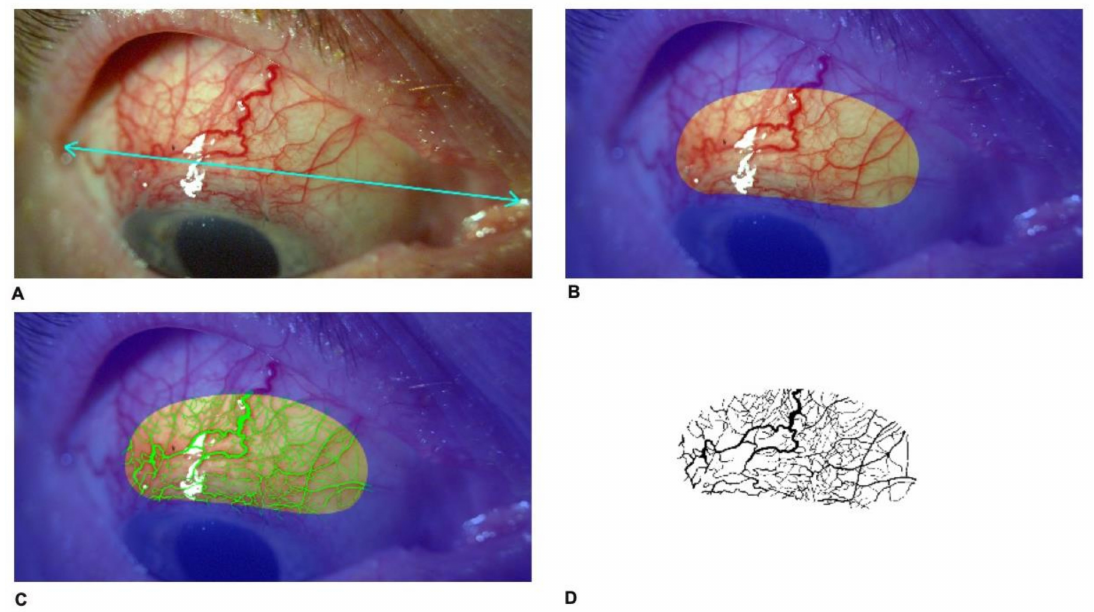
Figure 1. Slit-lamp anterior-segment photography of a filtering bleb 1 day after trabeculectomy. ( A ) Setting reference points (eye corners) on each standard photography in 10 × magnification (blue arrow). ( B ) Creation of a constant bean-shaped area of 4.994 cm 2 including scleral flap. ( C ) Adjusting the brightness of an image, increasing the contrast in RGB (red–green–blue) color model and enhancement of the green channel. The threshold was manually adjusted until the entire red area of vessels was highlighted in green. ( D ) After color correction of the photographs, processed masks were recorded as monochromatic (black and white) images and then black areas from the image were measured using ImageJ-aided quantification of black pixels to calculate the total vessel